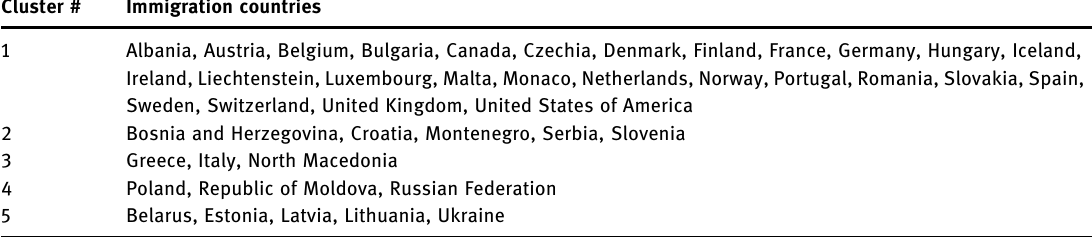
Table 4: Country memberships of immigration trait clusters, 2019 Cluster #